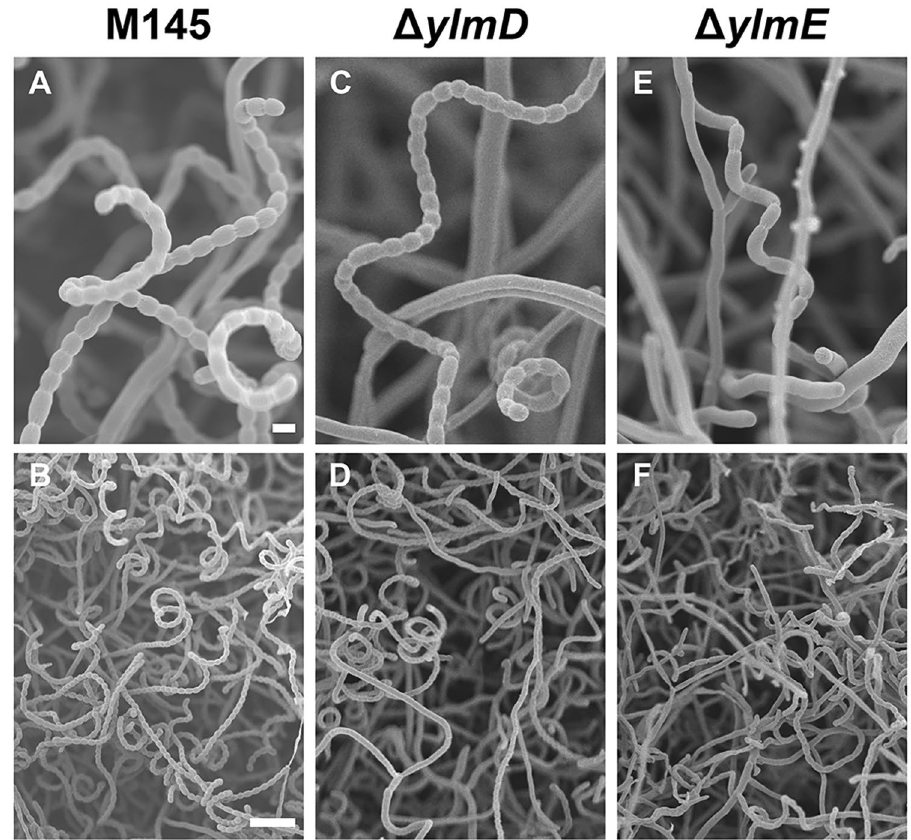
Figure 3. Cryo-scanning electron micrographs of aerial hyphae of S. coelicolor M145 and its ylmD and ylmE mutants. The parental strain produced wild-type spores, the ylmD mutant produced abundant but often irregular spores, while the ylmE null mutant produced occasional spores with highly irregular sizes. Cultures were grown on SFM agar plates for 5 days at 30 °C. Bars: top row, 1 μ m; bottom row, 5 μ